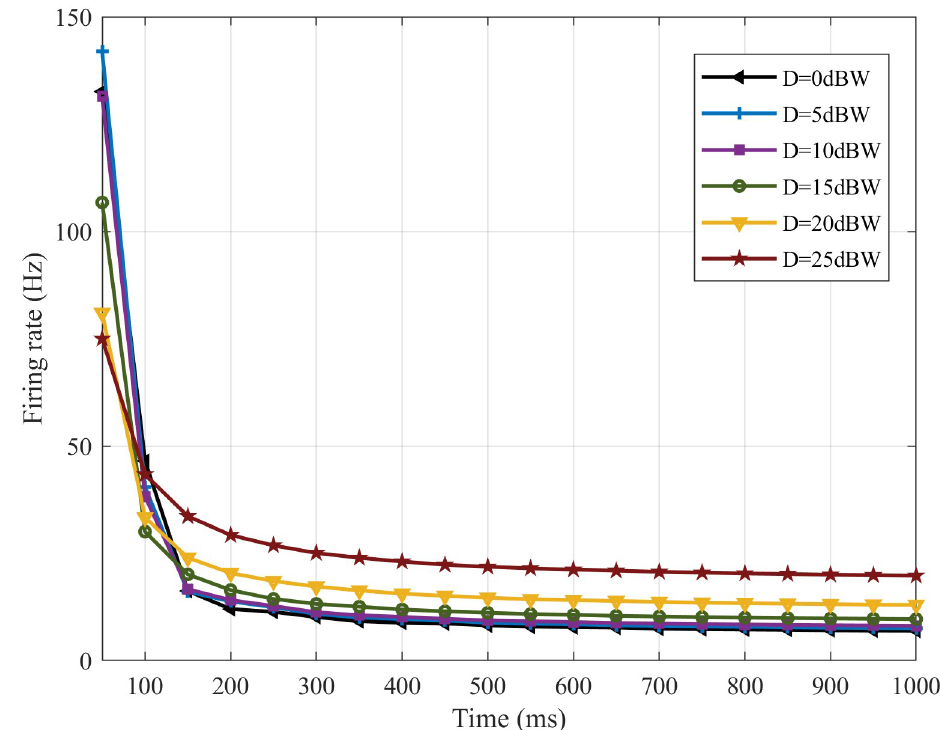
Fig 6. The change in the FR before and after noise stimulation.